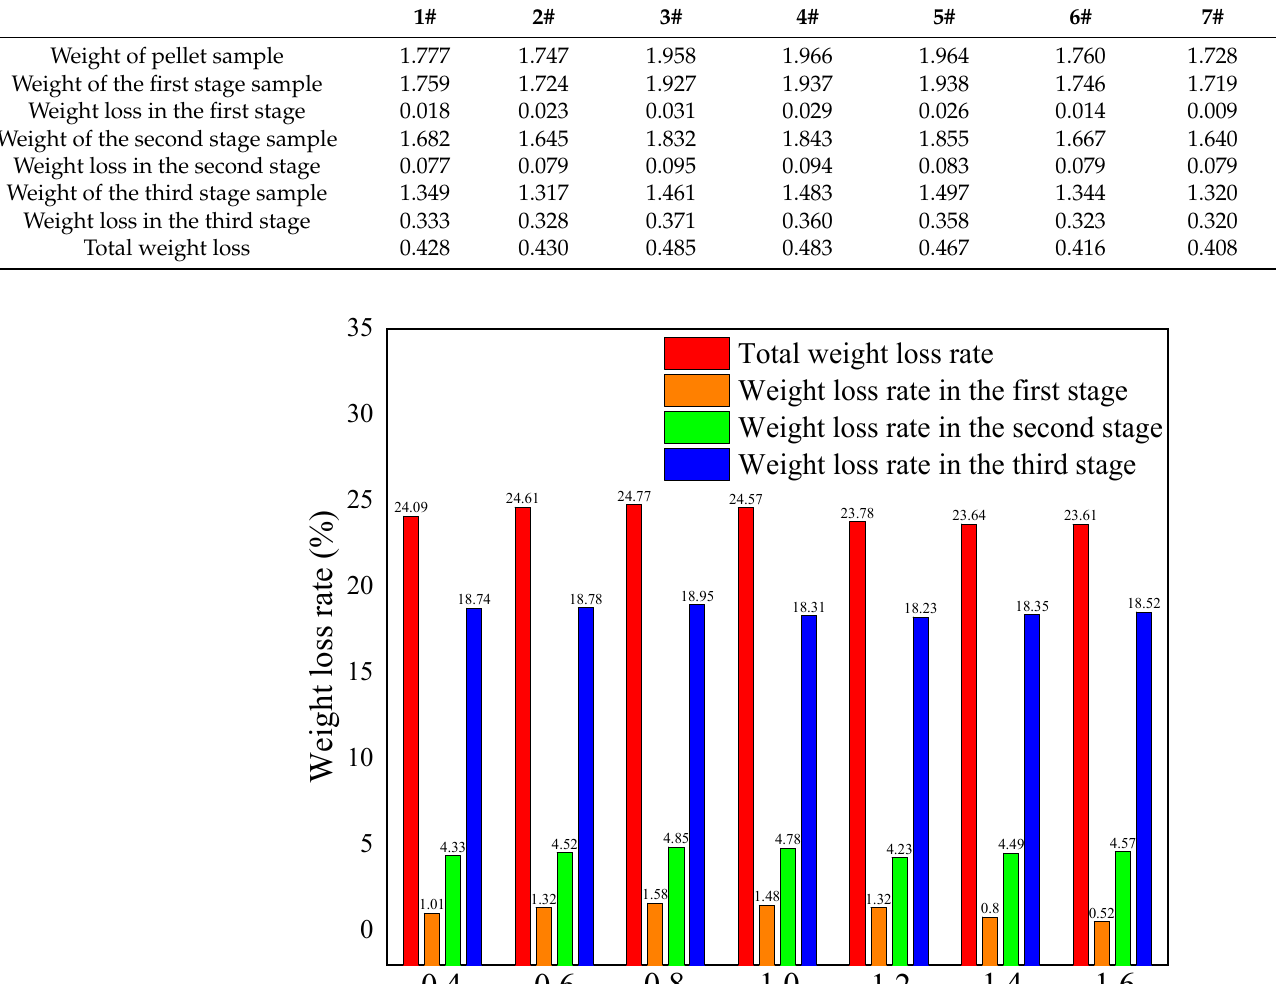
Figure 7 is the raw data of the weight-loss behavior in the reduction process of the pellets. The data regarding the weight loss in pellets extracted from Figure 7 are recorded in Table 8, and the data regarding the weight-loss rate of the pellets extracted from Figure 7 are drawn as Figure 8. Formulas (2)–(5) are the calculation formulas of the weight-loss rate and the total weight-loss rate of the pellets in the three stages with different basicities in Figure 8. Table 8. Pellet samples with different basicities lose weight at each stage of reduction/g.